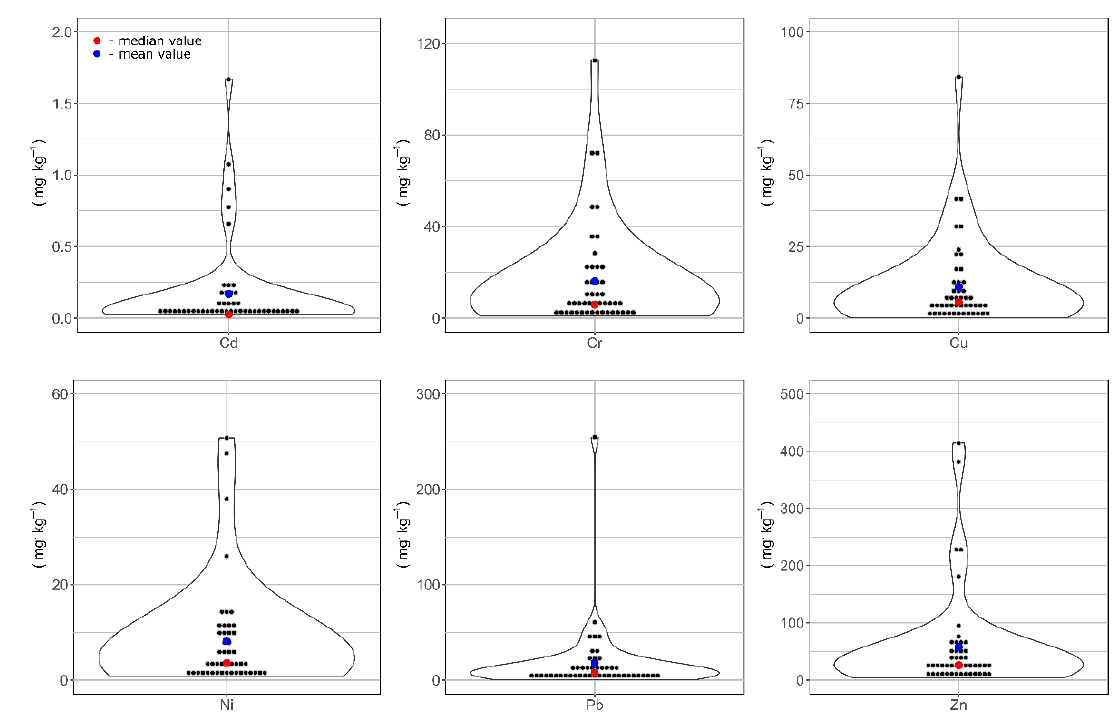
Figure 2. Violin plots showing the concentrations of individual HMs. Correlation analysis performed using Spearman’s test showed a high degree of cor- relation between the concentrations of Cu, Zn, Pb, Ni and Cr. This may indicate the same type of pollution sources and delivery pathway. Spearman’s correlation coefficient values were generally higher than 0.60 (Figure 3). In contrast, Cd concentrations were not asso- ciated with Ni and Cr (correlation coefficient values were 0.03) and relatively weakly cor- related with Cu, Pb and Zn (correlation coefficient values ranging from 0.29 to 0.32). This indicates a different pollution source and/or delivery pathway. Figure 3. Spearman correlation analysis results. 3.2. Sediment Contamination and Potential Toxic Effects of HMs The analysis of river sediments showed their local pollution with HMs. Considering EF values, the weakest pollution occurred for Cd (Figure 4). In 36 rivers, the values indi- cated no pollution, and in 9 rivers, they indicated minor enrichment. On the other hand, the highest pollution was recorded for Cr. The EF values were higher than 5 in 10 rivers, which indicates more than moderately severe enrichment. For other elements, EF values were higher than 5 in 5, 4, 3 and 3 rivers for Cu, Pb, Zn and Ni, respectively.